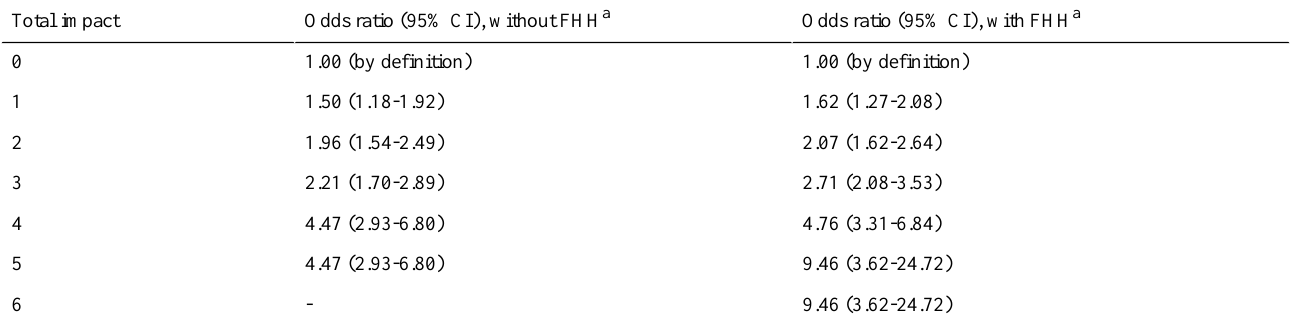
Table 7. Reference table for 5-SNP_Zheng